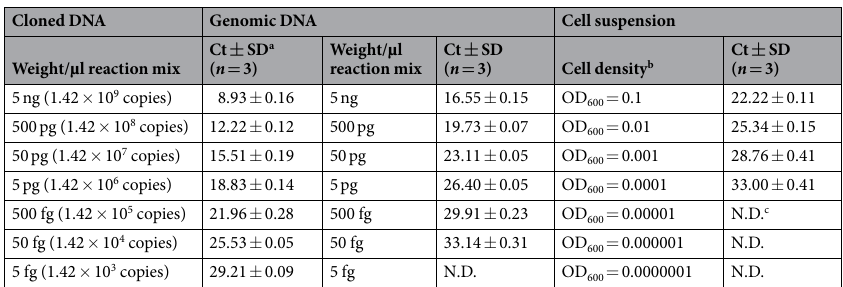
Table 4. Mean cycle threshold (CT) end-point fluorescence of 10-fold serial dilutions of Bacillus velezensis KACC 10116 cloned DNA, genomic DNA and a cell suspension determined with real-time PCR assay. a SD, Three reactions standard deviation. b OD = 600 nm. c N.D., Not